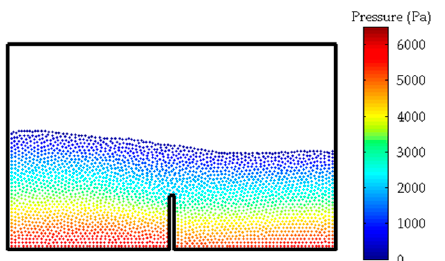
Figure 34. Flow pattern and pressure distribution in the SPH simulation with the baffle ( h = 1.33 ∆ x ,